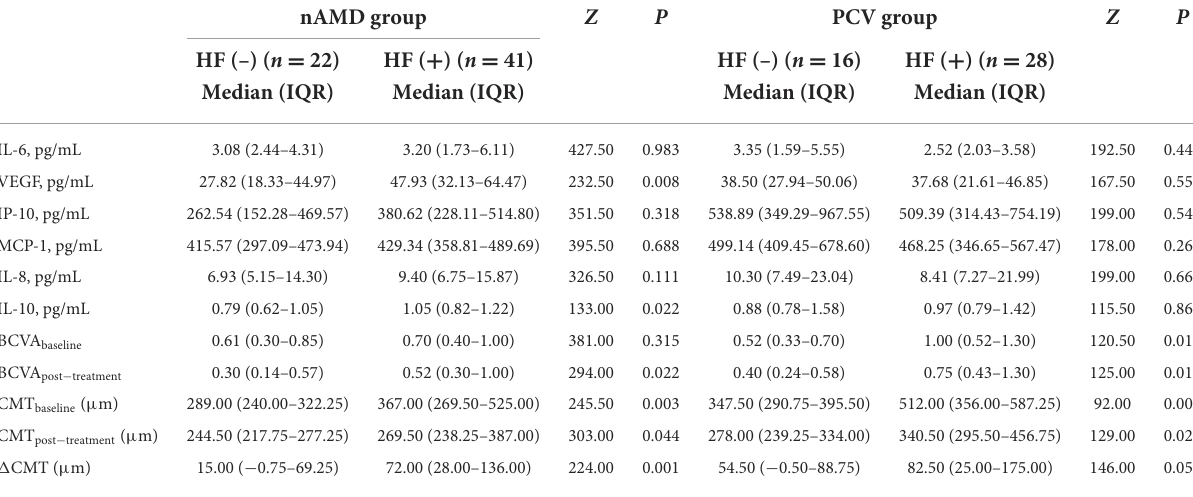
TABLE 2 AH concentrations (pg/mL) of cytokines, BCVA, and SD-OCT parameters in eyes with or without HF in the nAMD and PCV